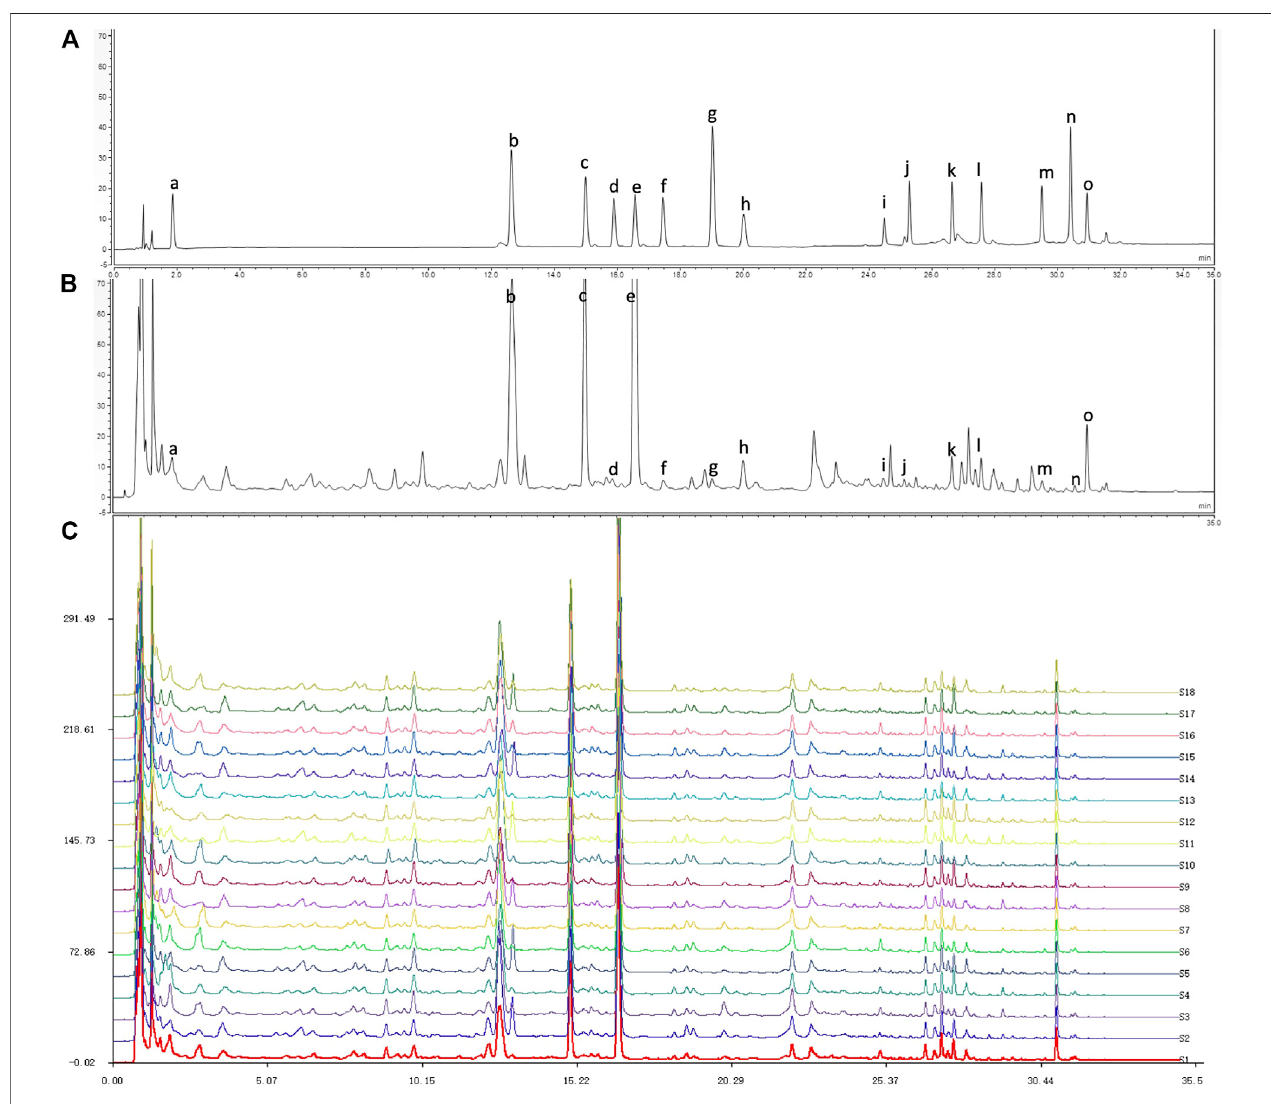
FIGURE 1 | UPLC-PDA chromatogram of reference substances (A) , test sample (B) and 18 batches of BBTD (C) . 15 peaks were identi fi ed by comparison with standardsubstances:Gastrodin(a),Liquiritin(b),Narirutin(c),Naringin(d),Hesperidin(e),Neohesperidin(f),Isoliquiritin(g),Liquiritigenin (h),Hesperetin (i),Isoliquiritigenin (j), Nobiletin (k), Protopine (l), Atractylenolide III (m), Poricoic acid A (n) and Glycyrrhetinic acid